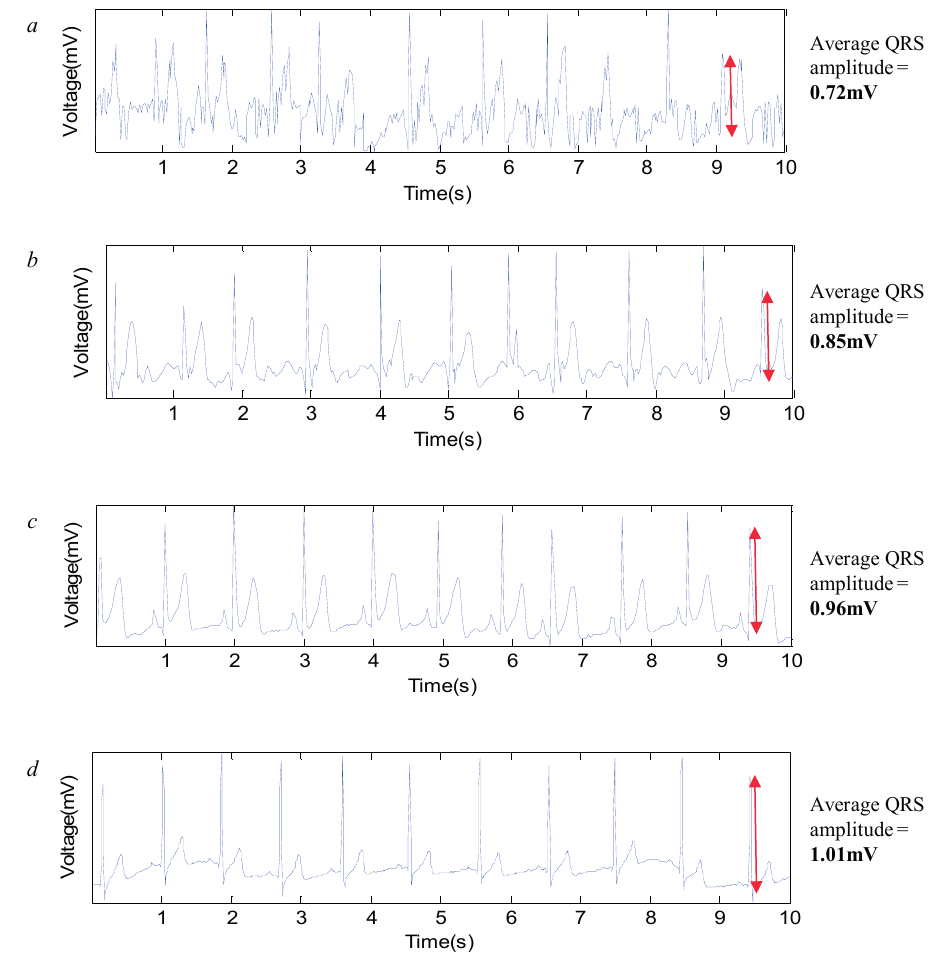
Figure 4. ECG signals captured with different sensor electrodes at different times. ( a ) CFE electrode at the first minute; ( b ) CFE electrode at the tenth minute; ( c ) FEEP electrode at the first minute; ( d ) FEEP electrode at the tenth